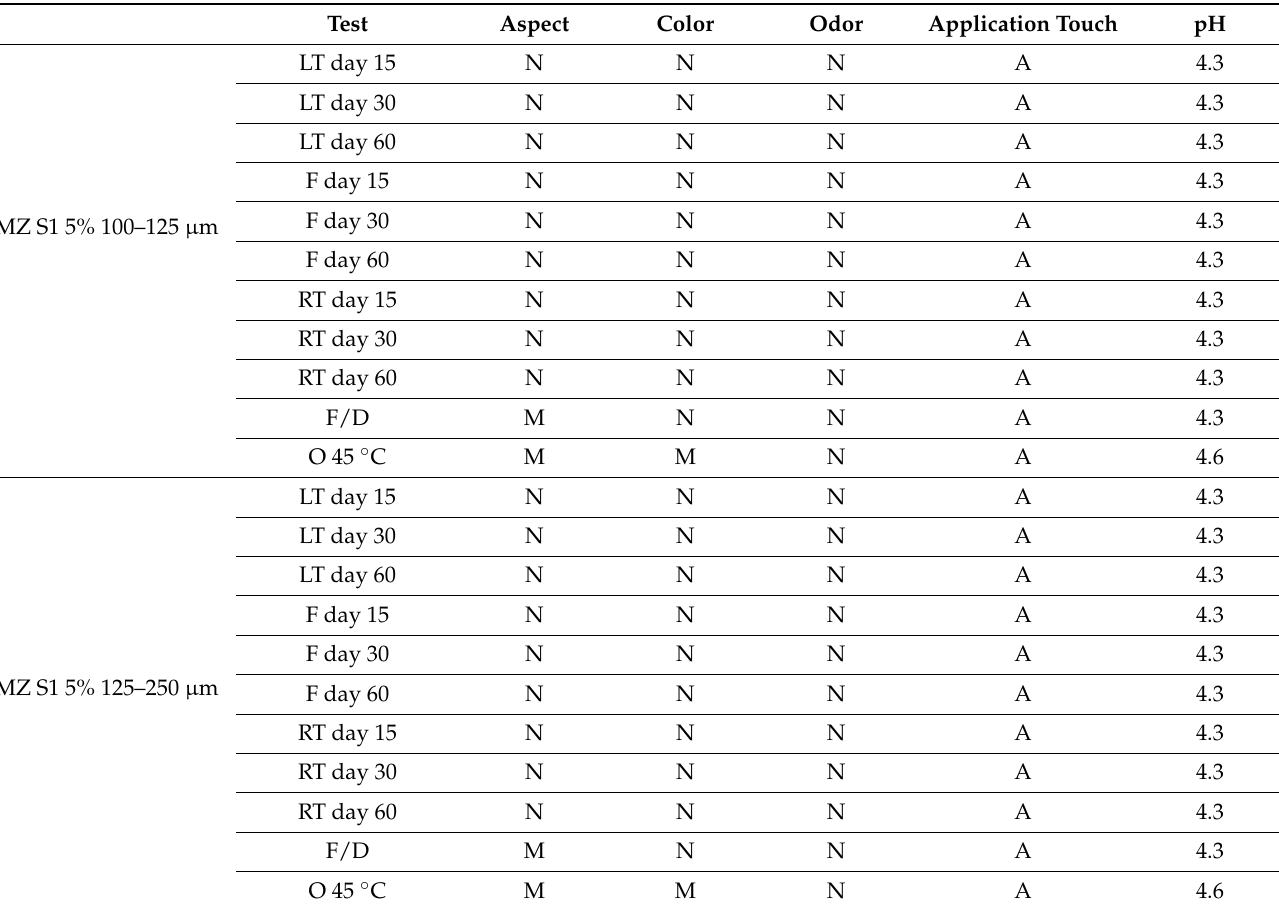
Table 6. Organoleptic characteristics and pH values of the cosmetic formulations in the accelerated stability study. Test Aspect